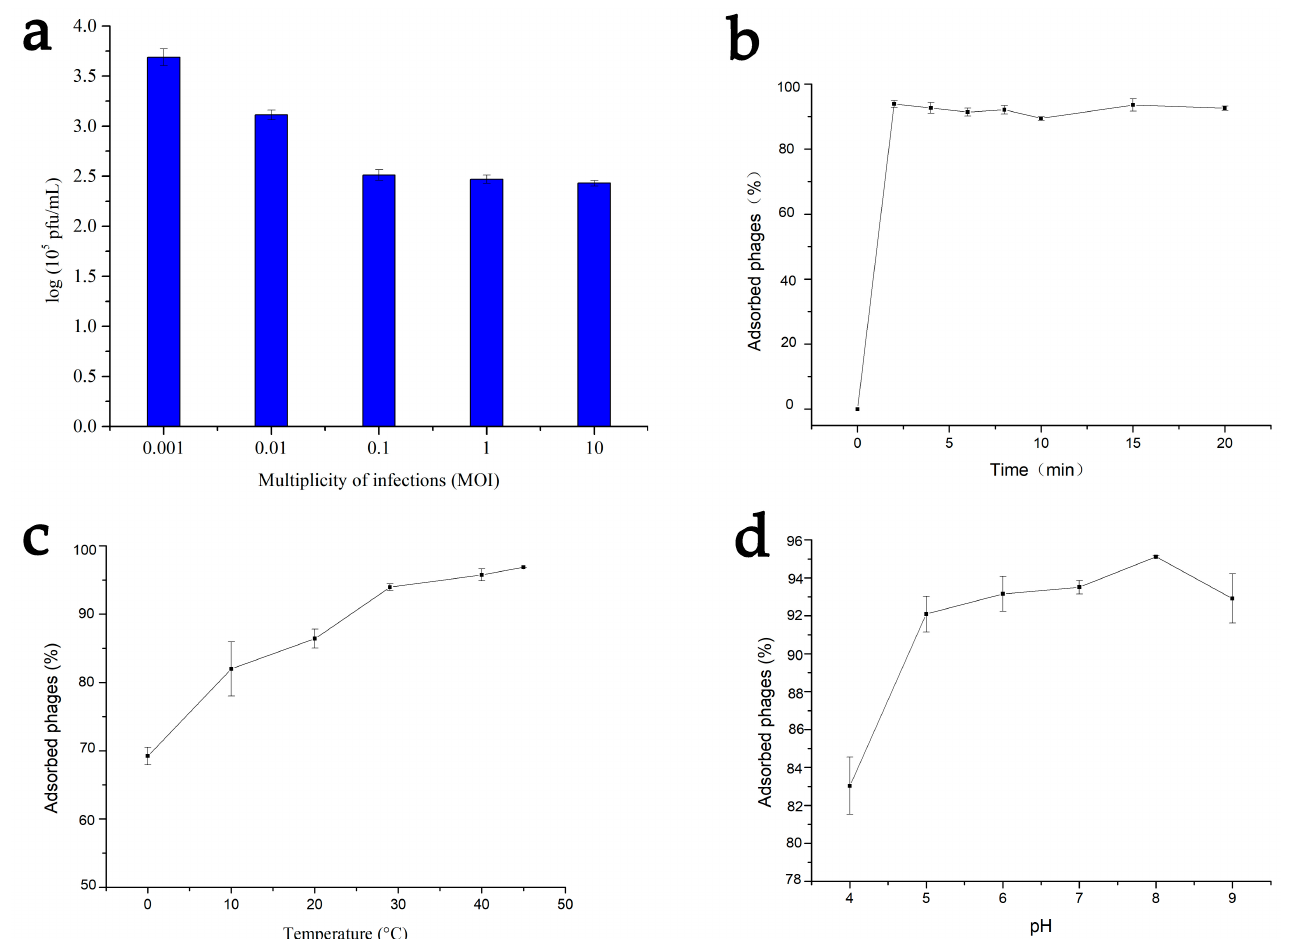
Figure 4. Multiplicities of infection (MOIs) curve ( a ), temporary adsorption kinetics of Vibrio phage Yong-XC31 ( b ), influence of temperature on adsorption kinetics ( c ), and influence of pH on adsorption kinetics ( d ). All the experiments were conducted with